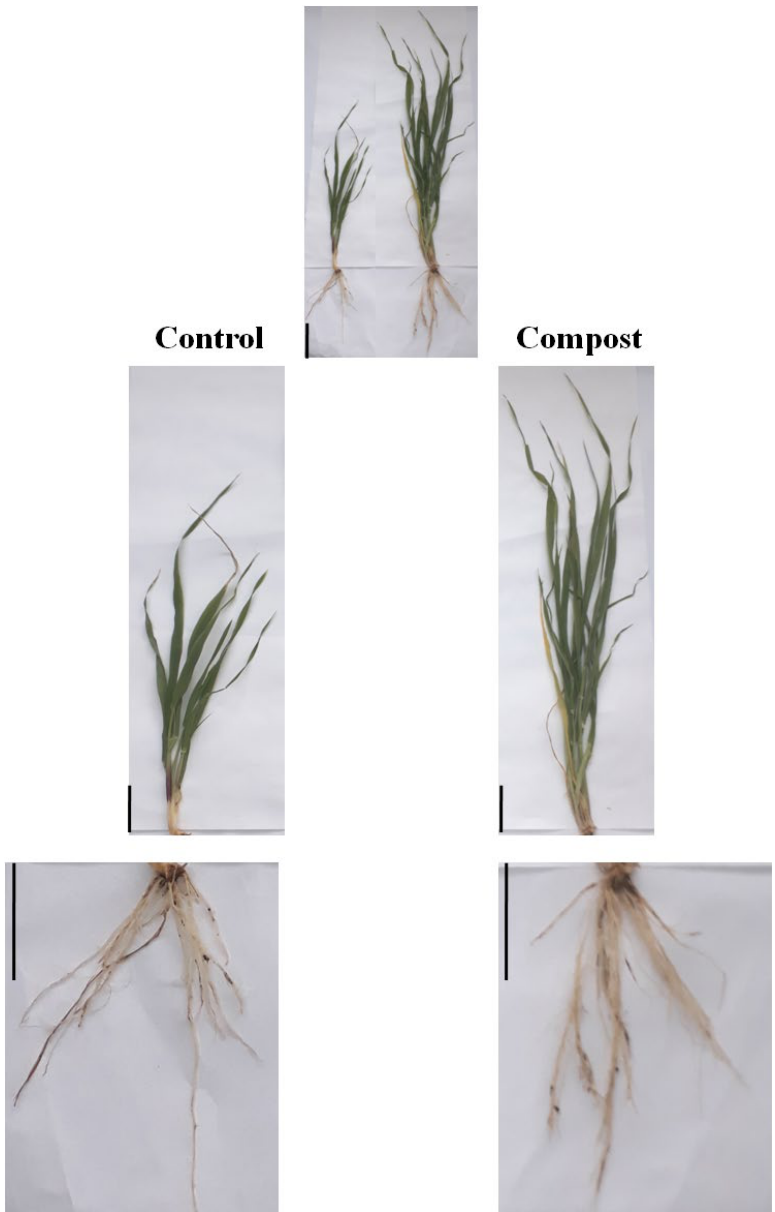
Figure 1. Morphological effects of date palm waste compost in shoots and roots of barley plants. Scale bars: 5 cm.